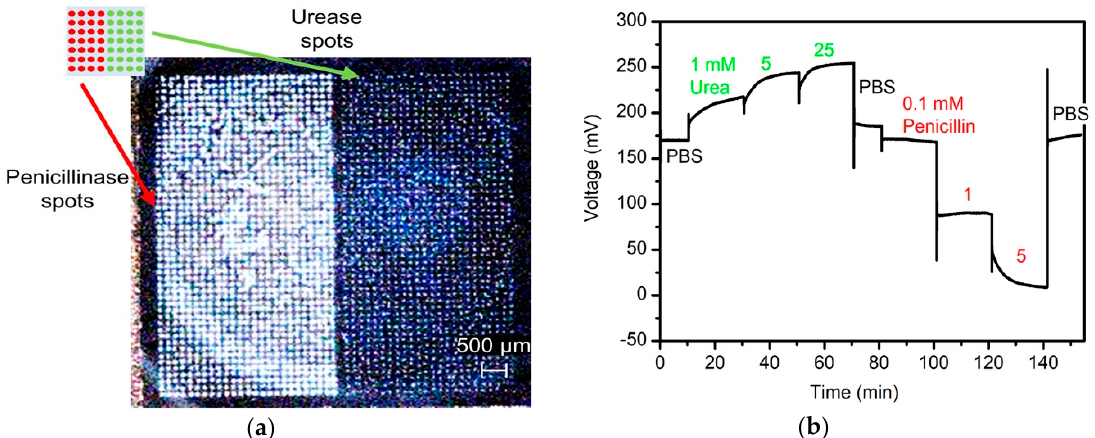
Figure 5 . ( a ) 3D video microscopic image of sensor surface with two immobilized enzymes by nano-spotting (schematic inlet on top for more clarification). ( b ) ConCap measurement of EIS multi-enzyme biosensor modified with half-spotted urease and half-spotted penicillinase measured first in polymix buffer solution and with different urea concentrations (1 mM to 25 mM), and then in PBS buffer and different penicillin concentrations (0.1 mM to 5 mM).